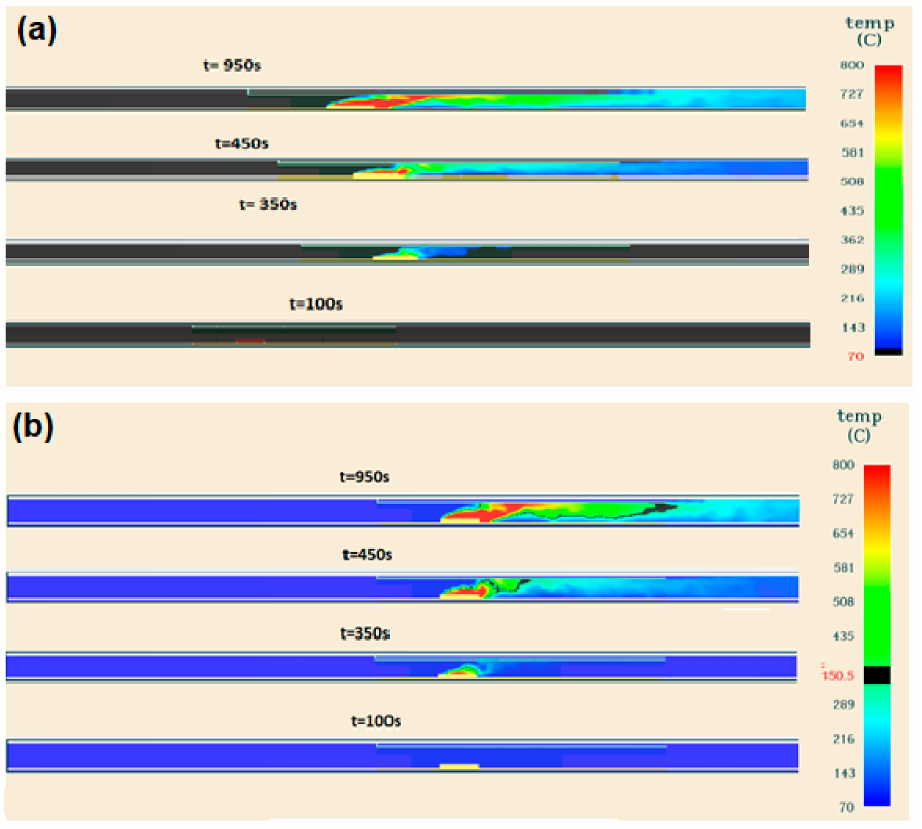
Figure 8. Contour plots of gas temperature with t = 100, 250, 350, 450, and 950 s for ( a ) T = 70 and ( b ) 350.5 ◦